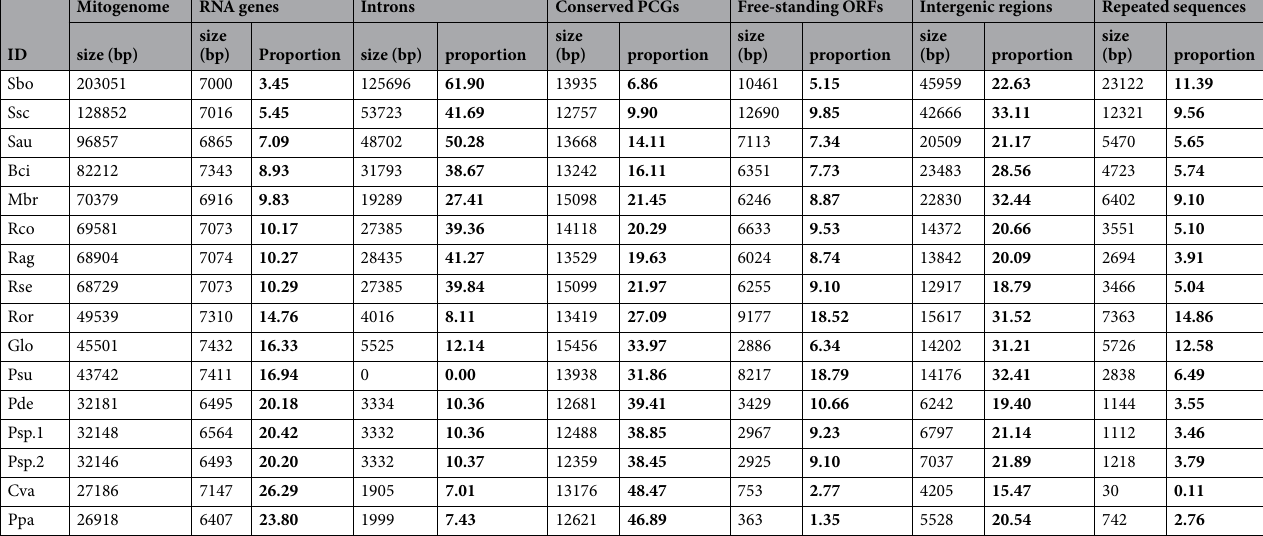
Table 2. The size of different mitochondrial regions and their proportion to the whole mitogenome. Species information in this table can be found in Supplementary Table S9.